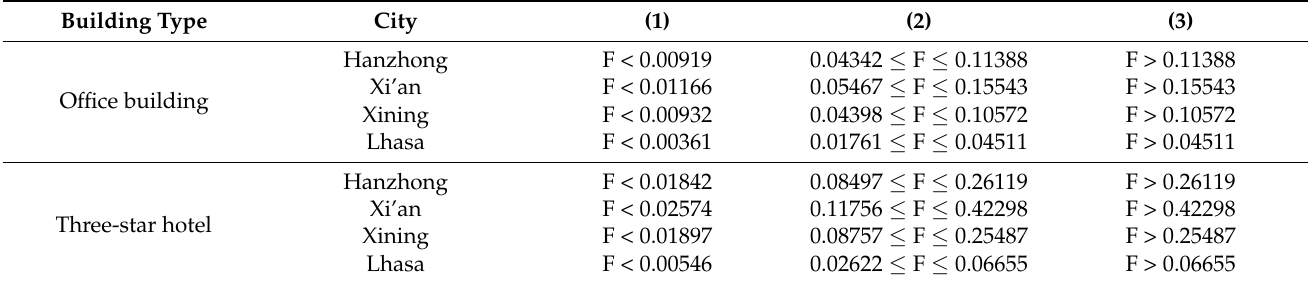
Table A2. Results of regional division using F for two types of buildings.